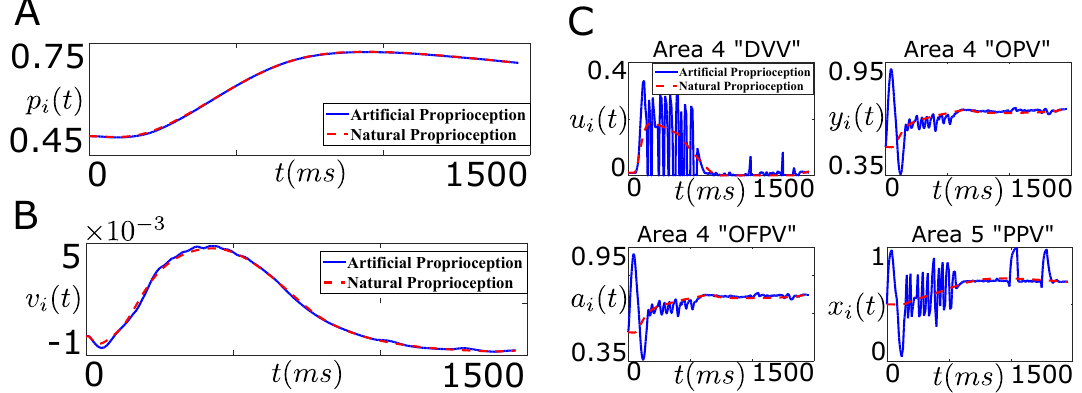
Figure 10. Performance of the designed closed-loop BMI in tracking the desired position trajectory (“Problem 1”, Figure 9A). ( A ) shows the position trajectory of the agonist muscle i in the presence of the designed artificial sensory feedback (solid line, blue) and the natural sensory feedback (dotted line, red); ( B ) shows the velocity trajectory of the agonist muscle i in the presence of the designed artificial sensory feedback (solid line, blue) and the natural sensory feedback (dotted line, red); ( C ) shows the average firing activity of a population of the cortical area 4 “DVV” neurons ( u i ( t ) ), “OPV” neurons ( y i ( t ) ), “OFPV” neurons ( a i ( t ) ), and the cortical area 5 “PPV” neurons ( x i ( t ) ) in the presence of the artificial sensory feedback (solid line, blue) and the natural sensory feedback (dotted line,